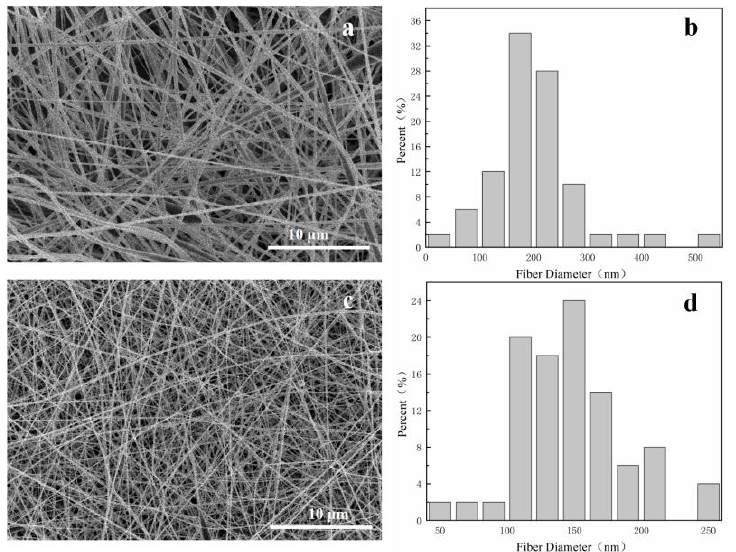
Figure 3. ( a ) SEM images of PVDF electrospun nanofibers under the process condition of 28 °C and 5:5 solvent volume ratio; ( b ) Diameter distribution histograms of ( a ). ( c ) SEM images of PVDF – AuNPs electrospun nanofibers under the process condition of 28 °C and 5:5 solvent volume ratio ( b ). ( d ) Diameter distribution histograms of ( c ).